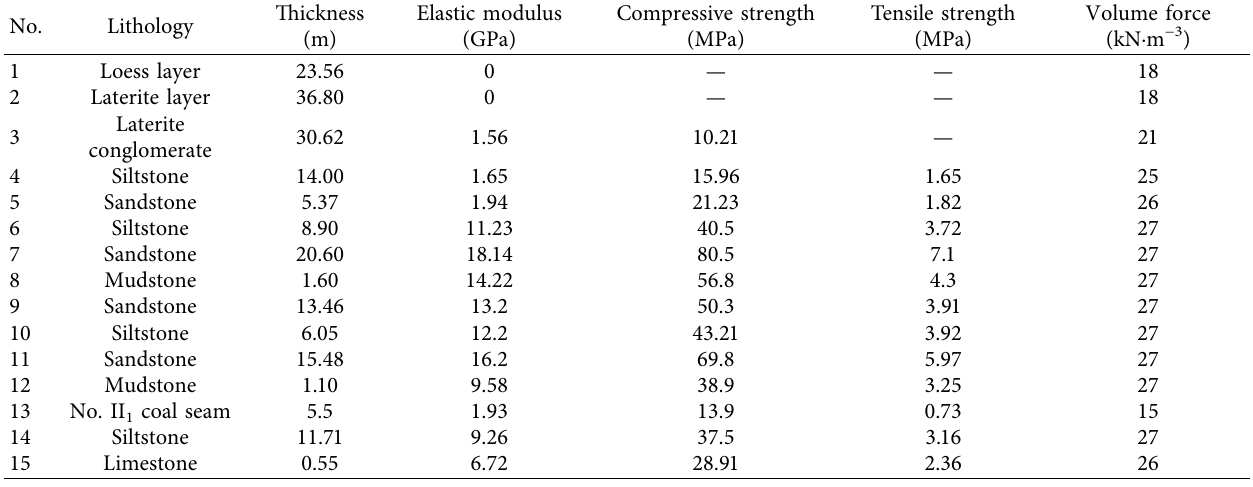
Table 2: Physical and mechanical parameters of overlying